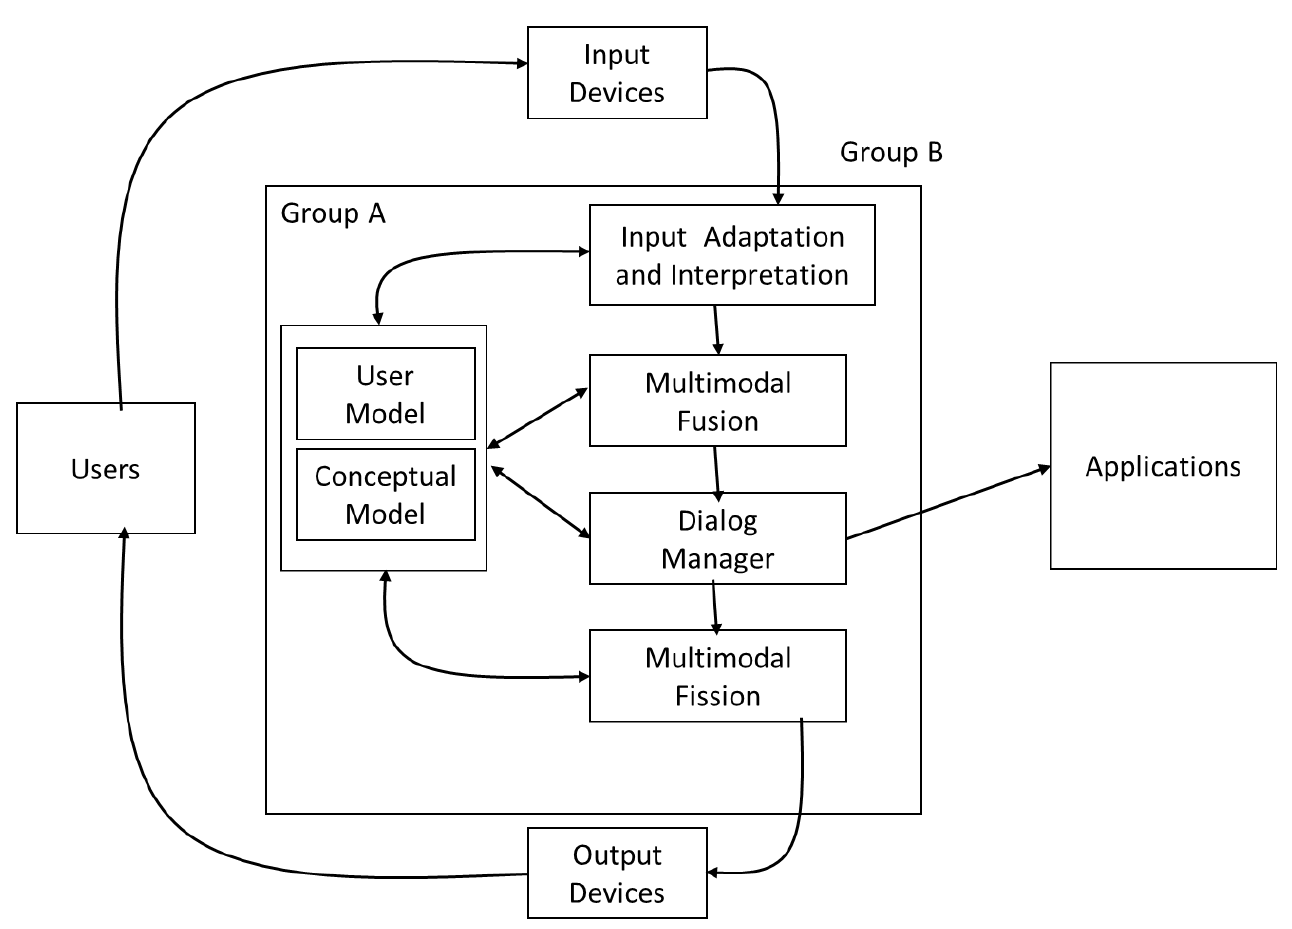
Figure 1: Framework’s Architectural